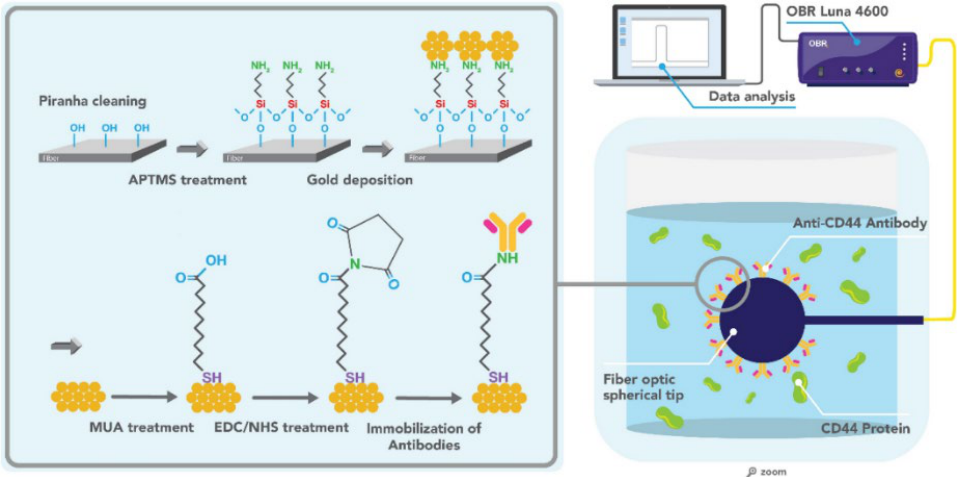
Figure 13. Schematic of functionalization of spherical tip-biosensor used for detection of CD44 biomarker (image reproduced from [131] ) .